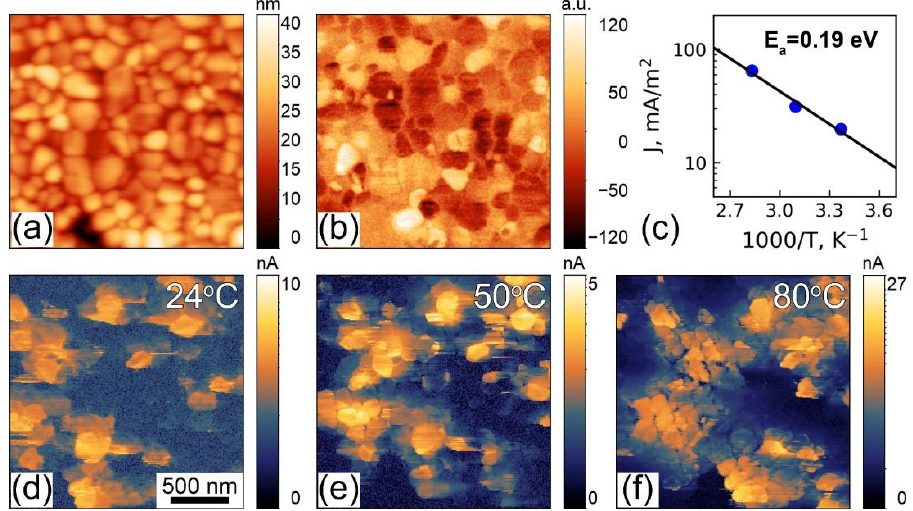
Figure 2. BFO thin film: ( a ) Topography, ( b ) out-of-plane PFM, ( c ) dependence of C-AFM current density (J) on reverse temperature, ( d – f ) CAFM in BFO thin film in dependence on temperature: ( d ) RT, ( e ) 50 °C, ( f ) 80 °C.